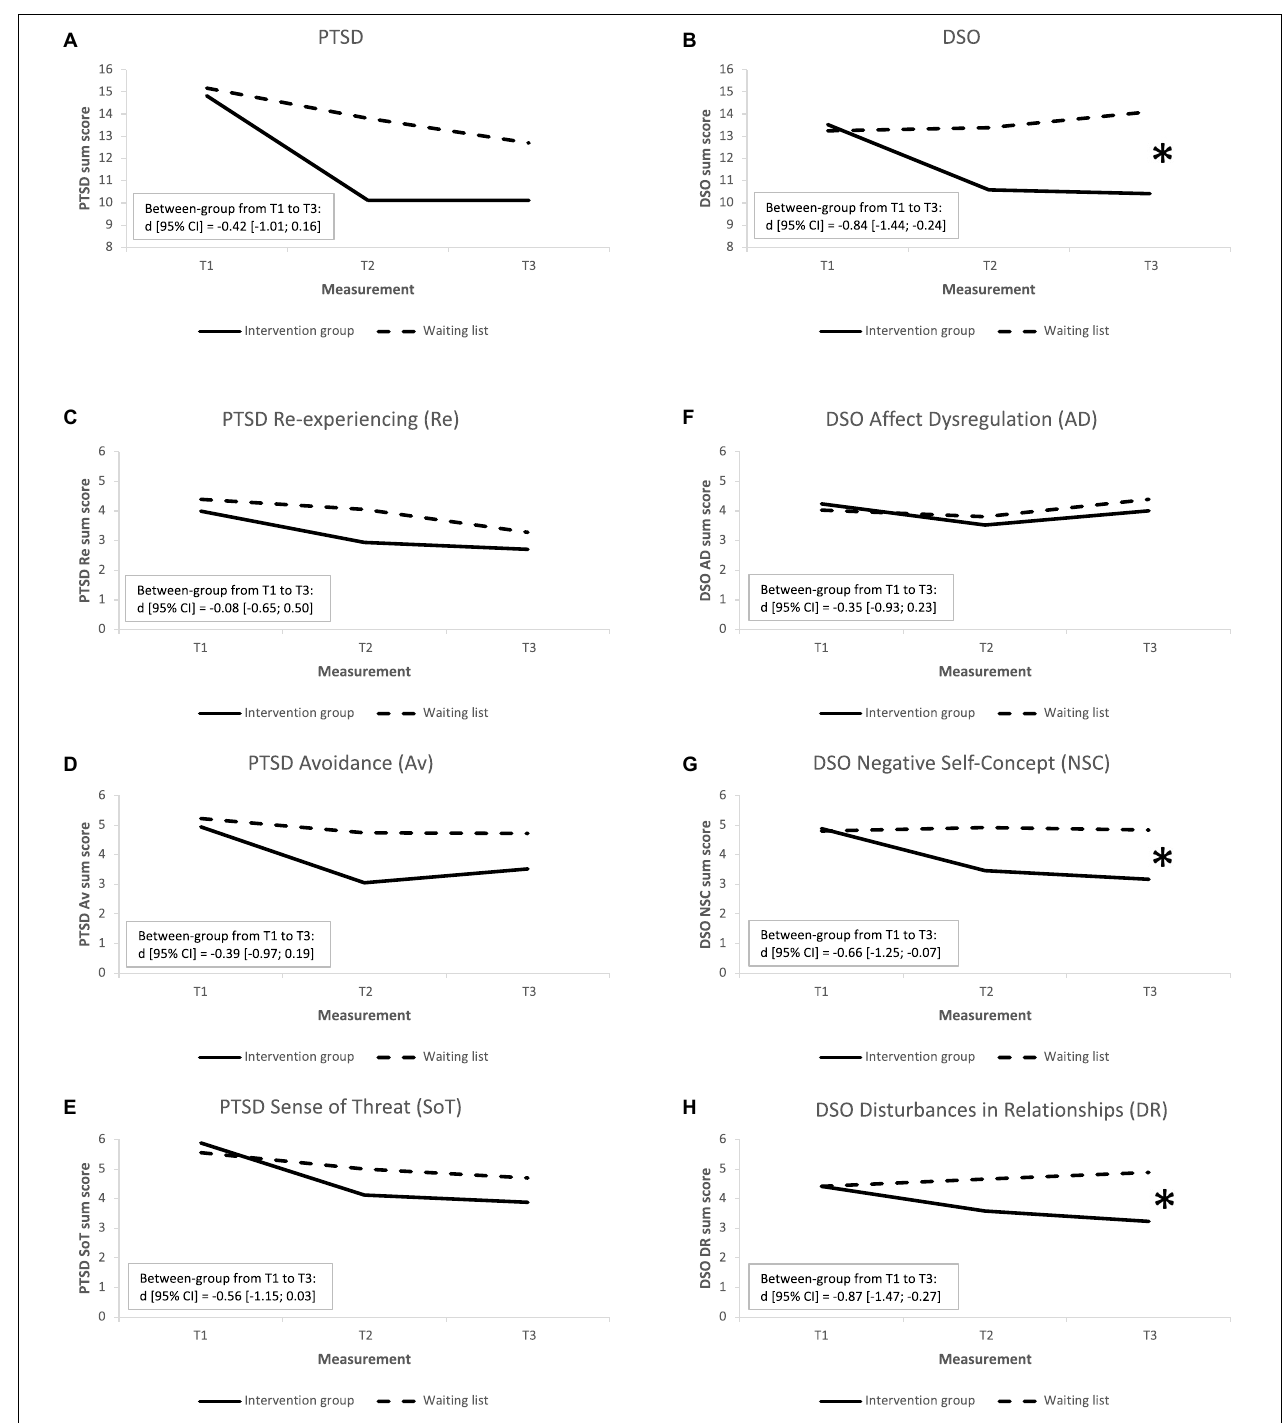
FIGURE 2 | Trajectories of change of intervention outcomes in the IG ( n = 17) and WL control group ( n = 36). (A) PTSD – posttraumatic stress disorder, (B) DSO – disturbances in self-organization, (C–E) PTSD symptom clusters, (F–H) DSO symptom clusters. * Between-group effect size from T1 to T3 is significant.